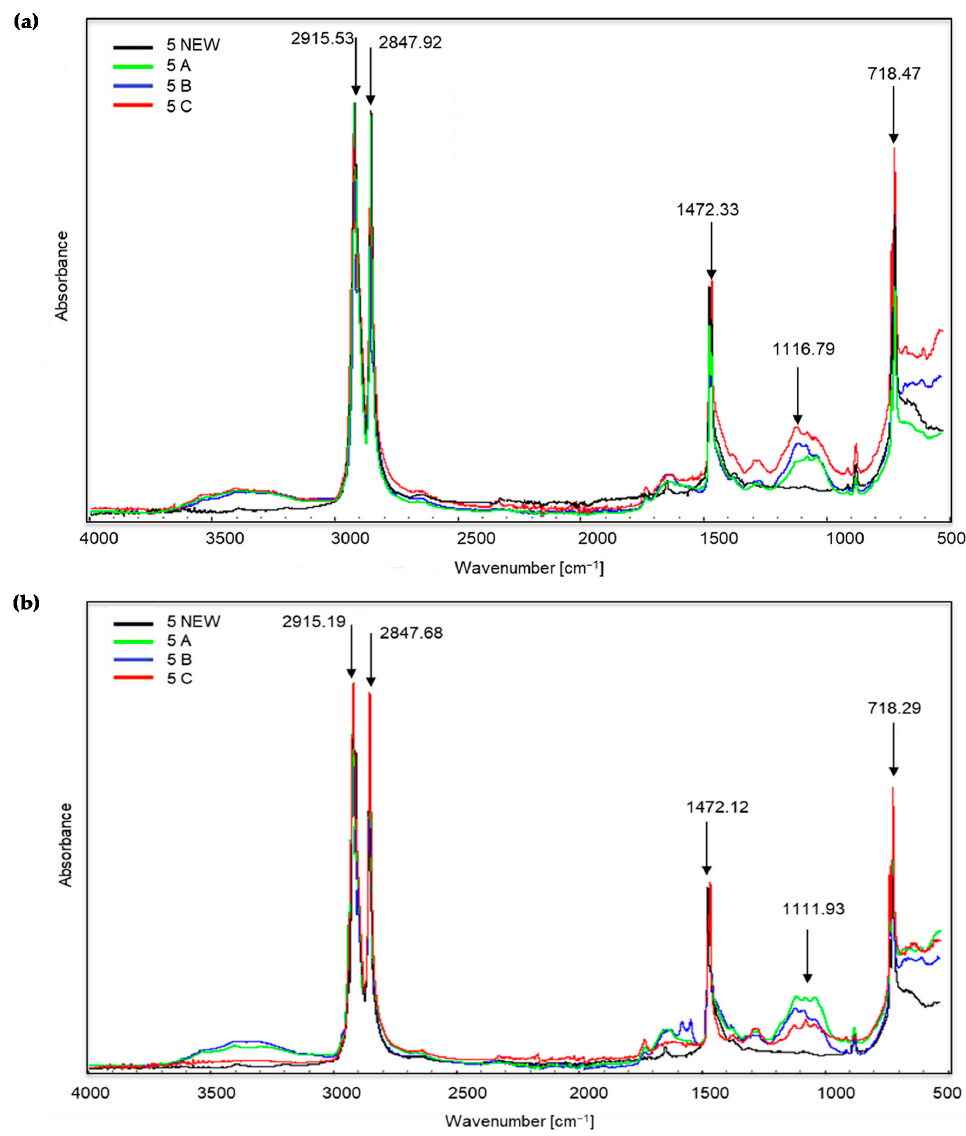
Figure 3. Sample no. 5 spectra: ( a ) spectra generated by the white part of the sample material, ( b ) spectra generated by the coloured part of the sample material.